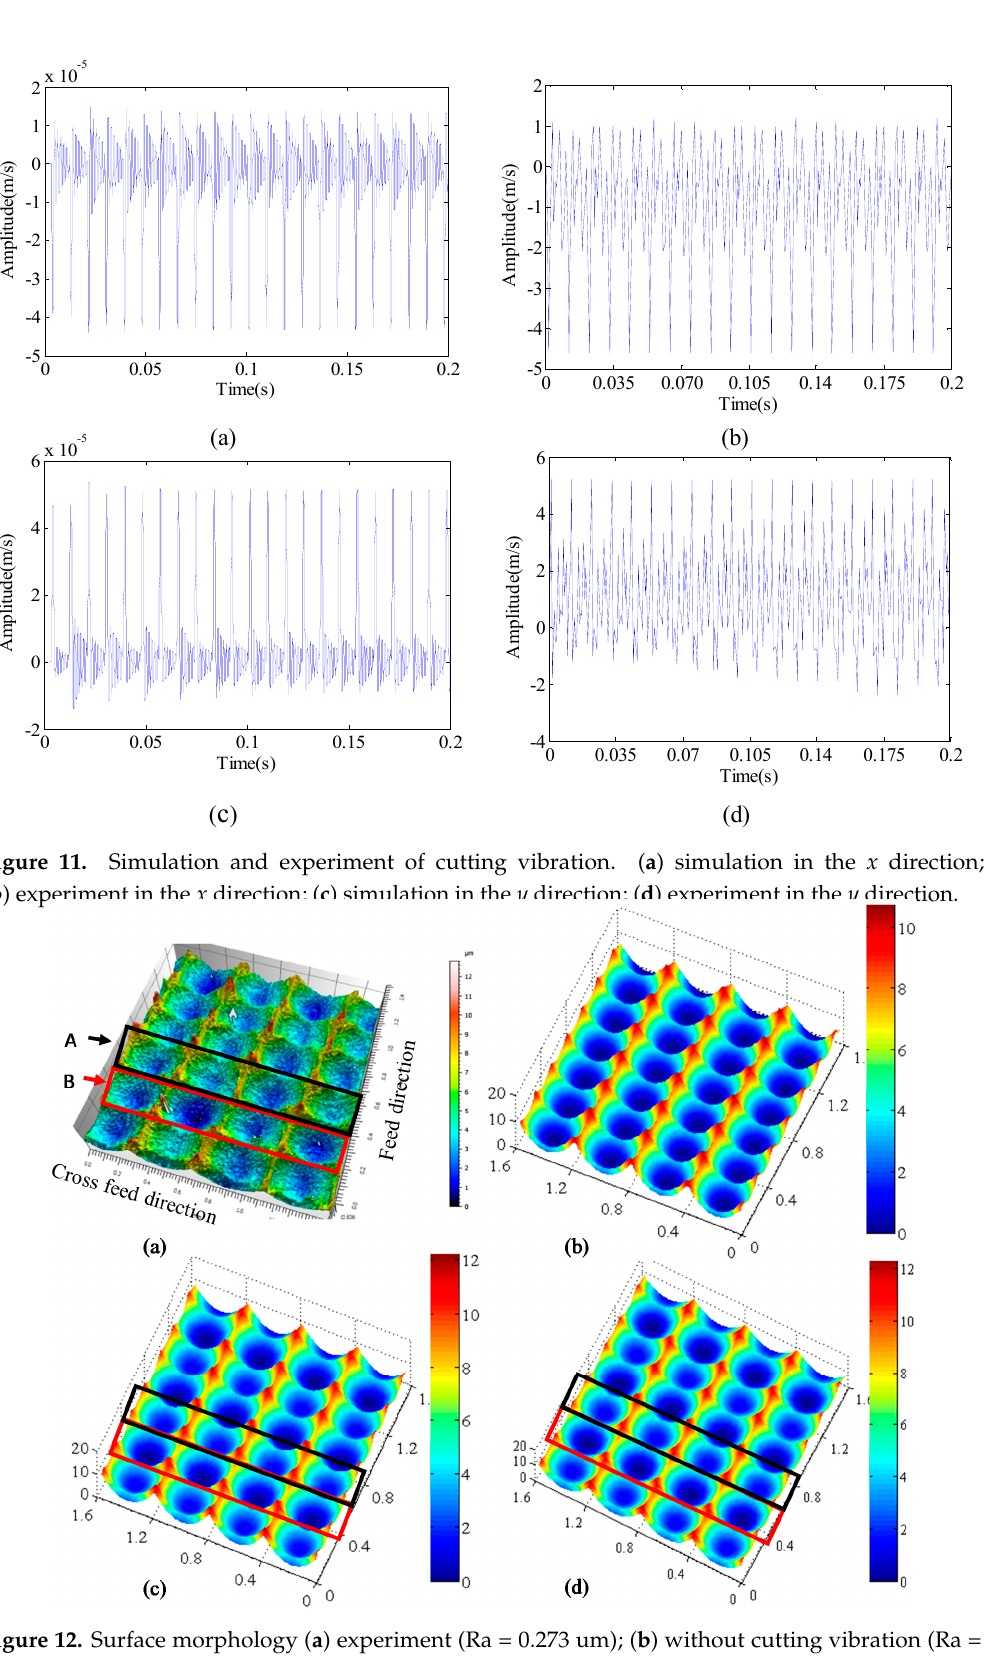
( b ) Figure 13. Simulation and experiment of surface roughness at different tool wear. VB—the tool wear. ( a ) effect of tool wear on surface roughness; ( b ) error. It can be seen from Figure 13 that the surface roughness increases with the increase of tool wear. When the tool wear amount is less than 0.164 mm, the surface roughness increases more slowly. When tool wear increases from 0.164 mm to 0.21 mm, the increase rate of surface roughness is close to 50%. When the tool wear is less than 0.164 mm, the maximum error between the surface roughness simulation and the experimental measurement is 12.3%, which is within the acceptable range. When the tool wear is 0.21 mm, the maximum error between the surface roughness simulation and the 0.04 0.06 0.08 0.1 0.12 0.14 0.16 0.18 0.2 0.220.20.3